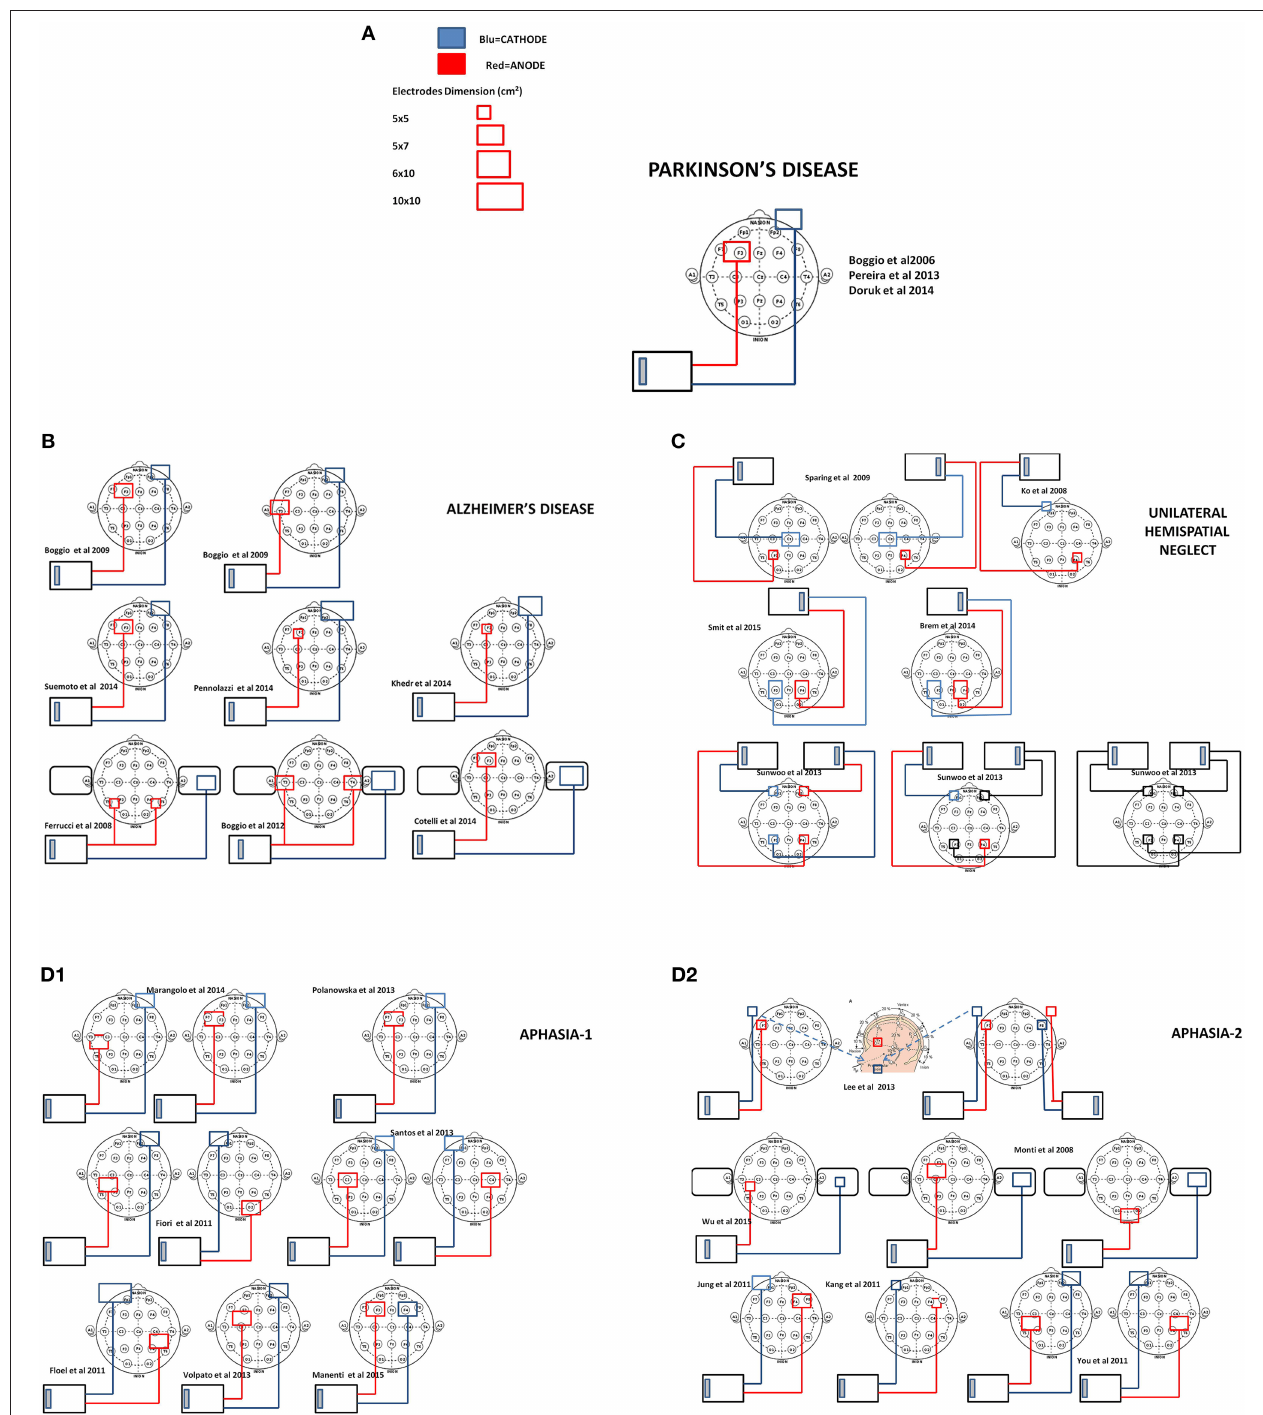
FIGURE 2 | Scale representation of tDCS electrode montage of the reviewed studies with reference to the EEG international 10–20 system. In (A) legend of electrodes size and polarity and electrode montage in Parkinson’s disease studies ( Boggio et al., 2006; Pereira et al., 2013; Doruk et al., 2014), (B) Alzheimer’s disease (Boggio et al., 2008, 2012; Ferrucci et al., 2008; Cotelli et al., 2014; Khedr et al., 2014; Penolazzi et al., 2014; Suemoto et al., 2014), (C) unilateral Neglect (Ko et al., 2008; Sparing et al., 2009; Sunwoo et al., 2013; Brem et al., 2014; Smit et al., 2015), and (D1,D2) Aphasia (Monti et al., 2008; Flöel et al., 2011; Fiori et al., 2011; Jung et al., 2011; Kang et al., 2011; You et al., 2011; Lee et al., 2013; Polanowska et al., 2013; Santos et al., 2013; Volpato et al., 2013; Marangolo et al., 2014; Manenti et al., 2015; Wu et al., 2015).